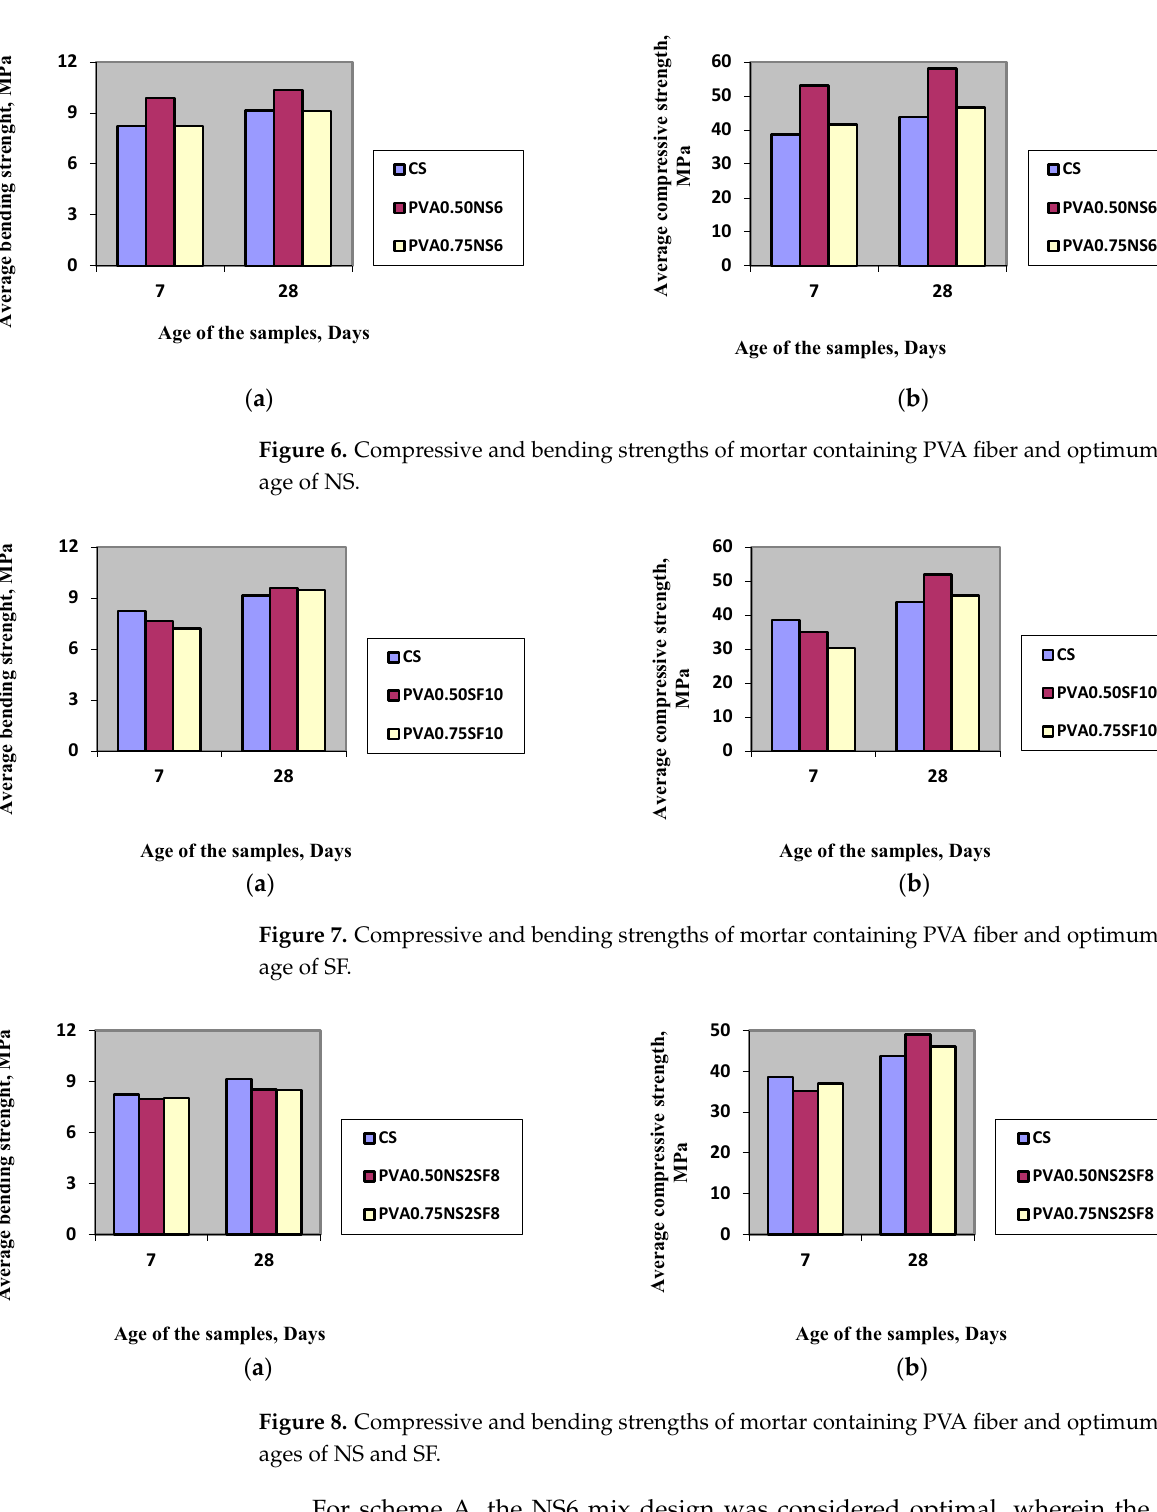
Figure 5. Compressive and bending strengths of mortar containing PVA fiber.